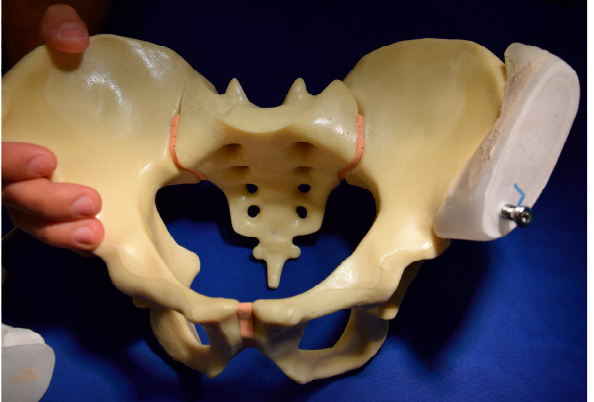
Figure A3. Standardised customised PMMA guide was used to predrill the entry points of the 5.0 mm Schanz screws with a 3.5 mm drill bit.